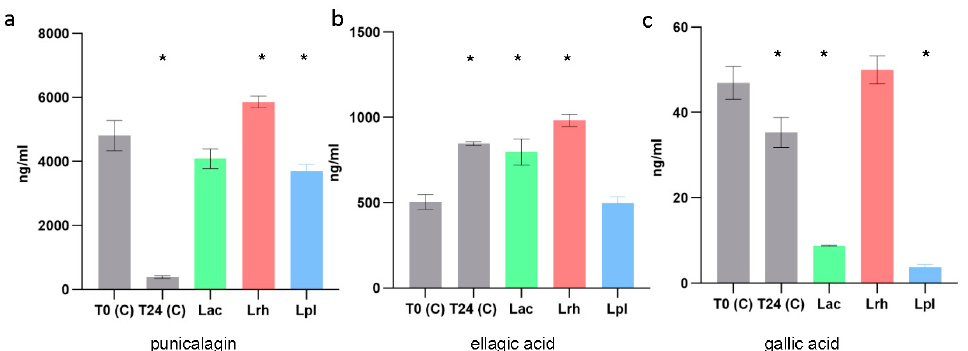
Figure 5. Targeted metabolite analysis for probiotic strains grown with POM extract 400 µg/mL. The ng/mL amount for each metabolite is shown on the y-axis, and the condition is on the x-axis. Punicalagin ( a ), ellagic acid ( b ) and gallic acid ( c ). Gray bars show the control conditions without bacteria. T0 (C): SDM control medium with P400 at 0 h; T24 (C): SDM control medium with P400 at 24 h; Lac: L. acidophilus ; Lrh: L. rhamnosus ; and Lpl: L. plantarum . Error bars show standard deviation of the mean, and * indicates a p value ≤ 0.05 when compared to the control T0.